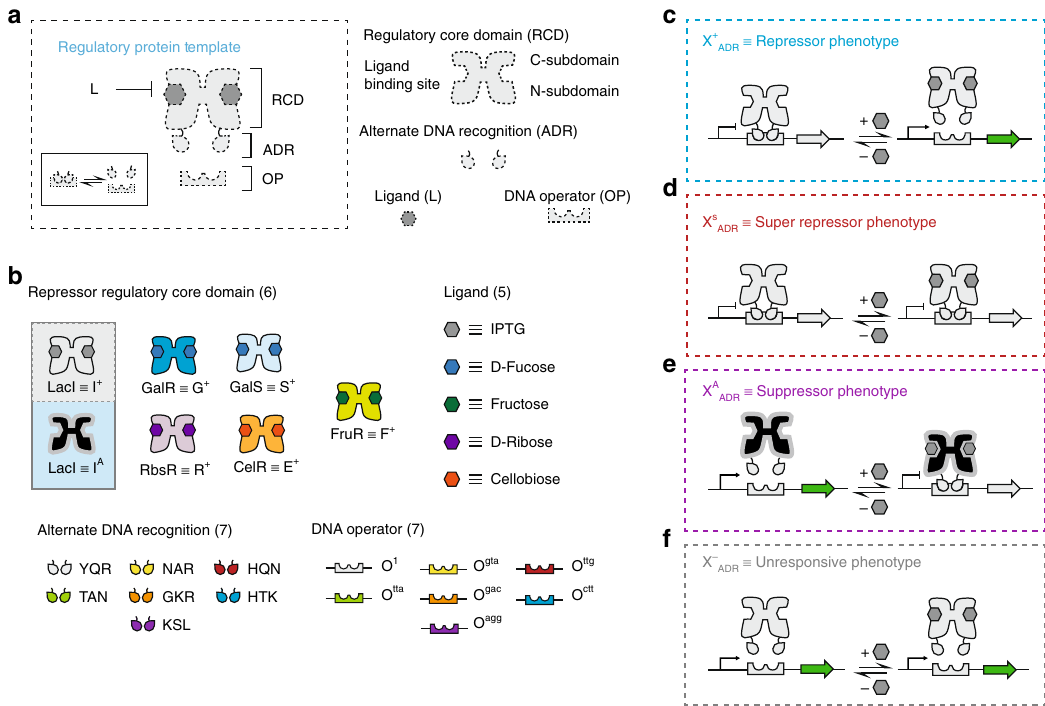
Fig. 1 Work fl ow for generating X ADR transcription factors. a Top panel illustrates the regulatory protein template. This system consists of three parts: a dimeric transcription factor (TF) along with its corresponding ligand (L), and its cognate DNA operator (OP). The interaction between the protein and its operator is modulated by binding of a complementary ligand and the system exchanges between the operator bound and unbound states (inset). The TF can be divided into two components, the regulatory core domain, or RCD and the (alternate) DNA recognition unit (ADR). The regulatory core domain can be further divided into the N- and C-subdomains, with the ligand binding domain at the cleft formed between the two. b Middle panel shows the discrete modules utilized in this work encompassing six regulatory core domains corresponding to fi ve distinct ligands and seven Alternate DNA Recognition (ADR) units along with the corresponding DNA operator elements. The modules can be exchanged to yield a total of 42 combinations including 7 I A ADR that have been previously reported. TF function can be classi fi ed into four distinct phenotypes. c The X + or repressor phenotype inhibits gene expression in the absence of inducer by binding to the operator. Gene expression is induced when the repressor undergoes a conformational shift upon binding ligand. d The X S or super-repressor phenotype cannot be induced either due to an inability to bind ligand, shift conformation, or dissociate from the operator sequence. e The X A or suppressor phenotype allows gene expression in the absence of ligand. Whereas, binding of the ligand results in inhibition of gene expression. f The X − or nonfunctional phenotype is incapable of inhibiting gene expression either from an inability to properly assemble or associate with its